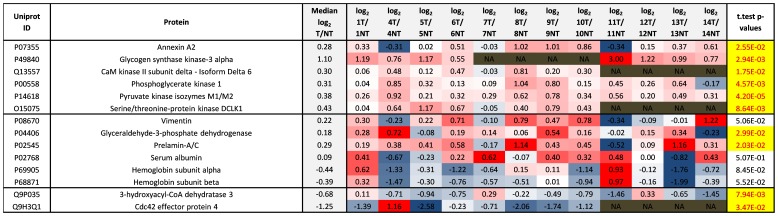
Mesenchymal (Vimentin), general cellularity and blood protein markers.Log2 T/NT ratios of the non-phosphorylated peptides from each protein were used as surrogates to calculate the relative abundance of the respective proteins. Log2 T/NT ratios of the non-phosphorylated peptides were averaged over three arms of the workflow (IMAC, TiO2, Non-enrich).